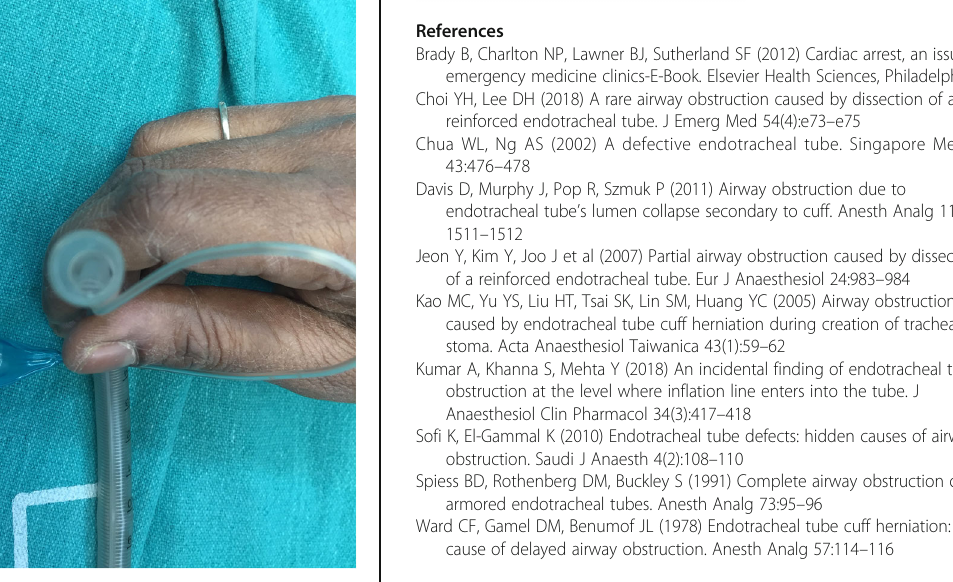
Fig. 2 Complete luminal obstruction where the inflation line joins the tube near the proximal end of the armoured tube, when the cuff is